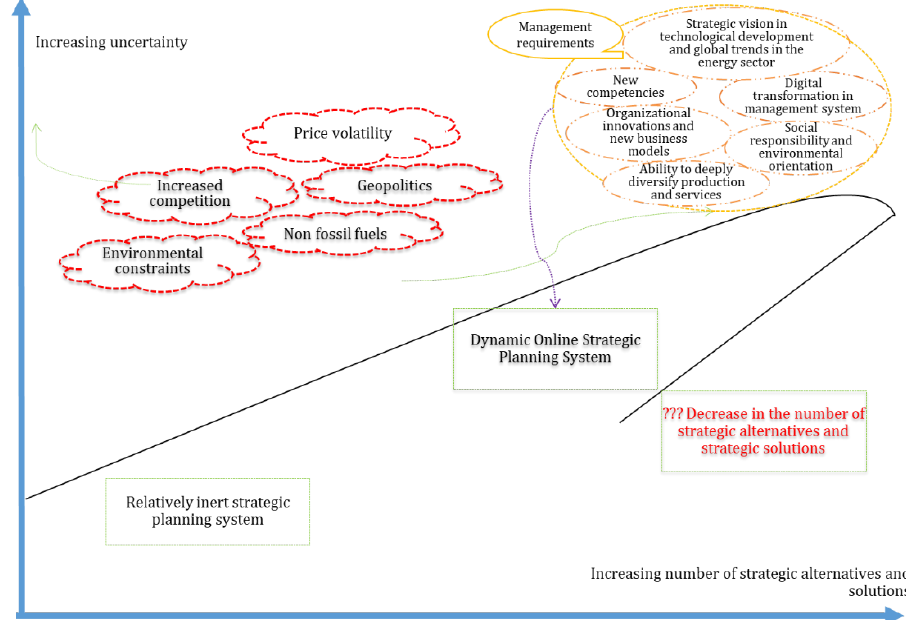
Figure 5. Changes in strategic management requirements under the transformation of the energy sector and global disturbances. Source: Created by the authors.